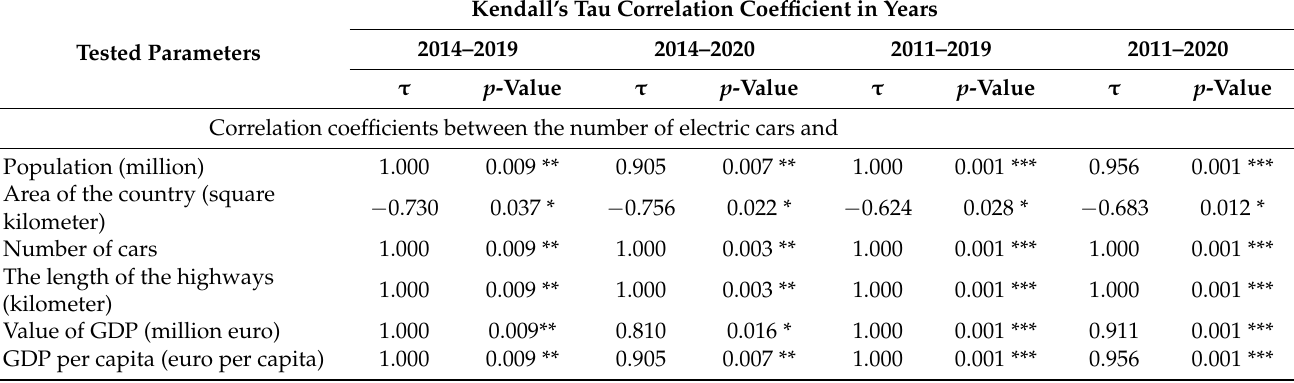
Table 5. Kendall’s tau correlation coefficients between the number of electric cars and social and economic parameters in